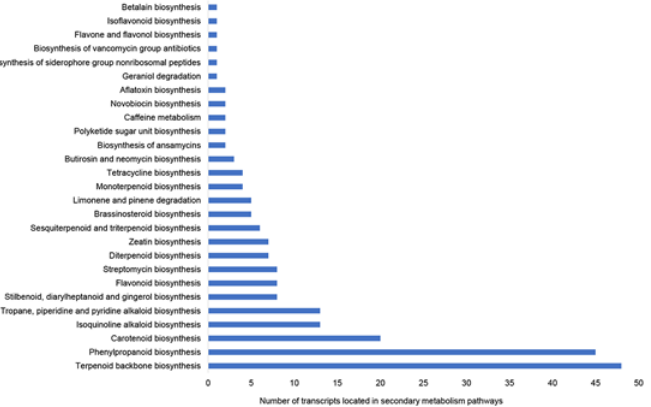
Fig 2. The KEGG pathways involved in secondary metabolism in C . deserticola . KEGG classification based on secondary metabolite categories sorted by counts of transcripts in a single